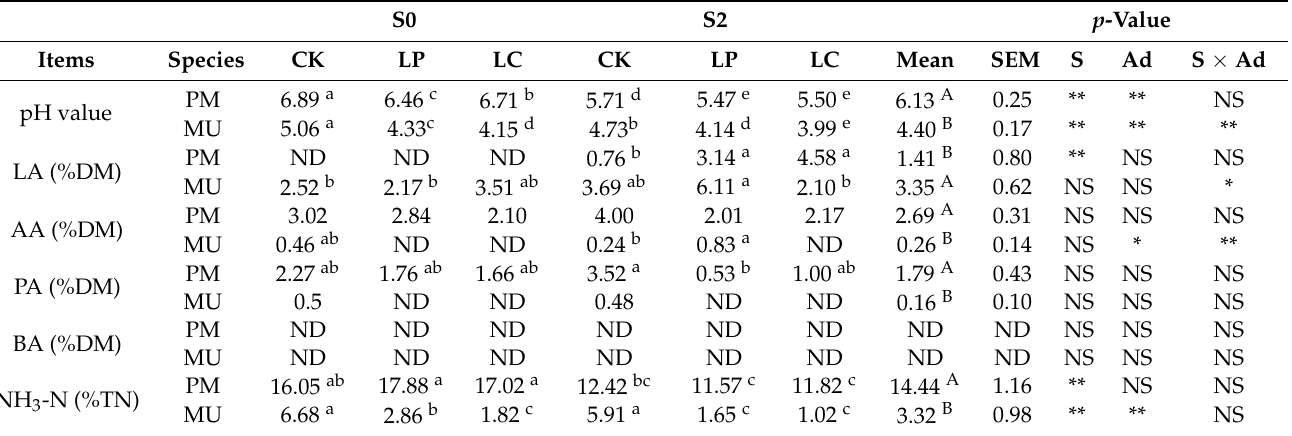
Table 2. The effect of sucrose and additives on fermentation quality of woody forage silages. S0 S2 p -Value